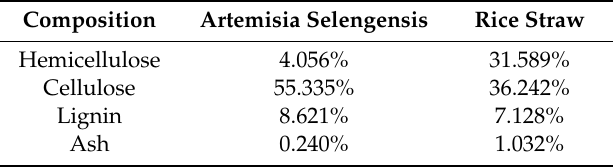
Figure 1. Artemisia selengensis from Baguazhou. Table 1. Artemisia selengensis cellulose